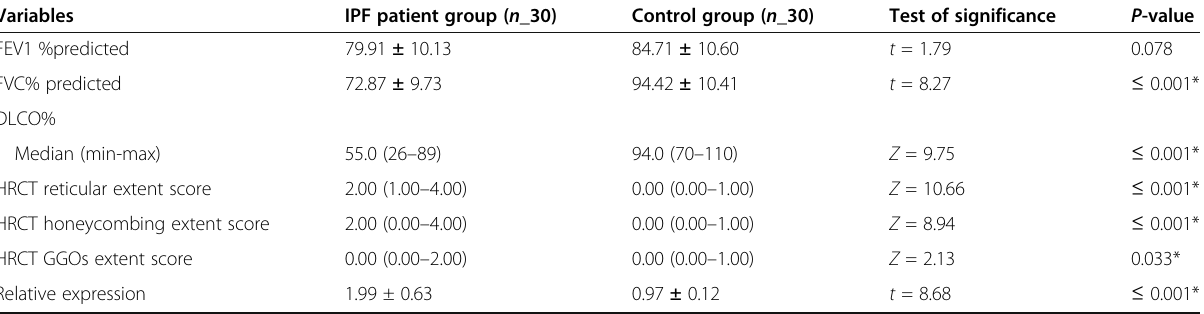
Table 2 Comparison between IPF patients and control groups regarding pulmonary function tests, UIP pattern in HRCT, and relative expression of TERRA mRNA